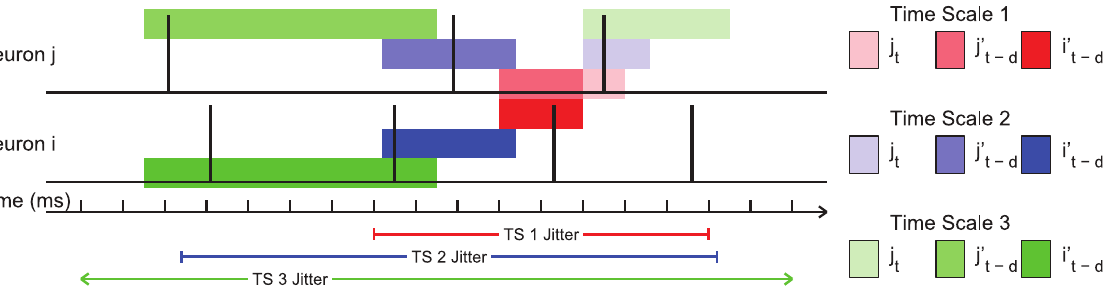
Fig. 10. Binning structure for short time scales on example spike trains. Note that the time scales overlapped to some degree to capture interactions with all delays and that time scales greater than 1 possessed delays to prevent short time scale interactions from influencing long time scale